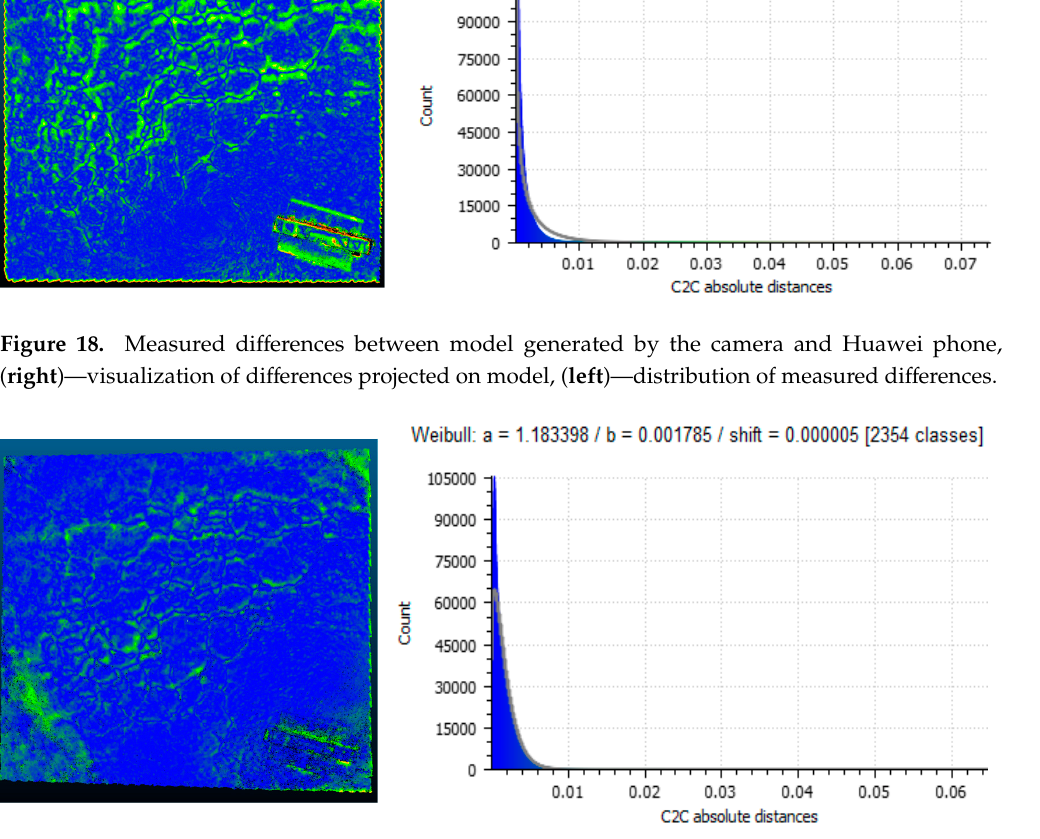
Figure 19. Measured differences between model generated by the camera and Samsung phone, ( right )—visualization of differences projected on model, ( left )—distribution of measured differences.